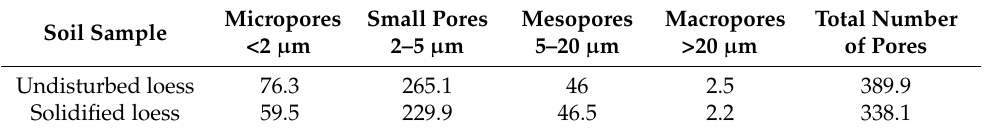
Table 4. Number of different types of Table 3. Areas of different types of pores ( μ m 2 ).